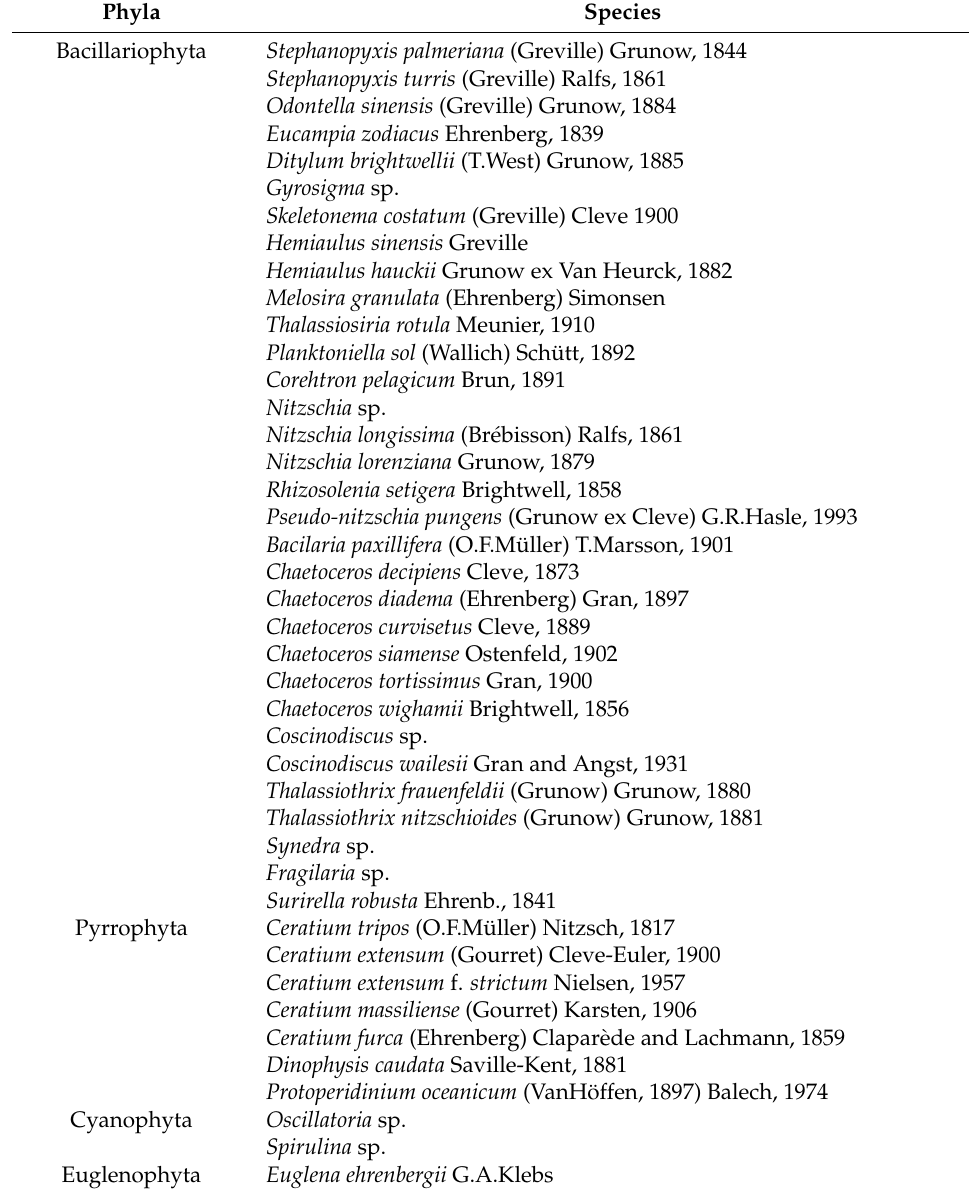
Table A1. List of phytoplankton in the waters of